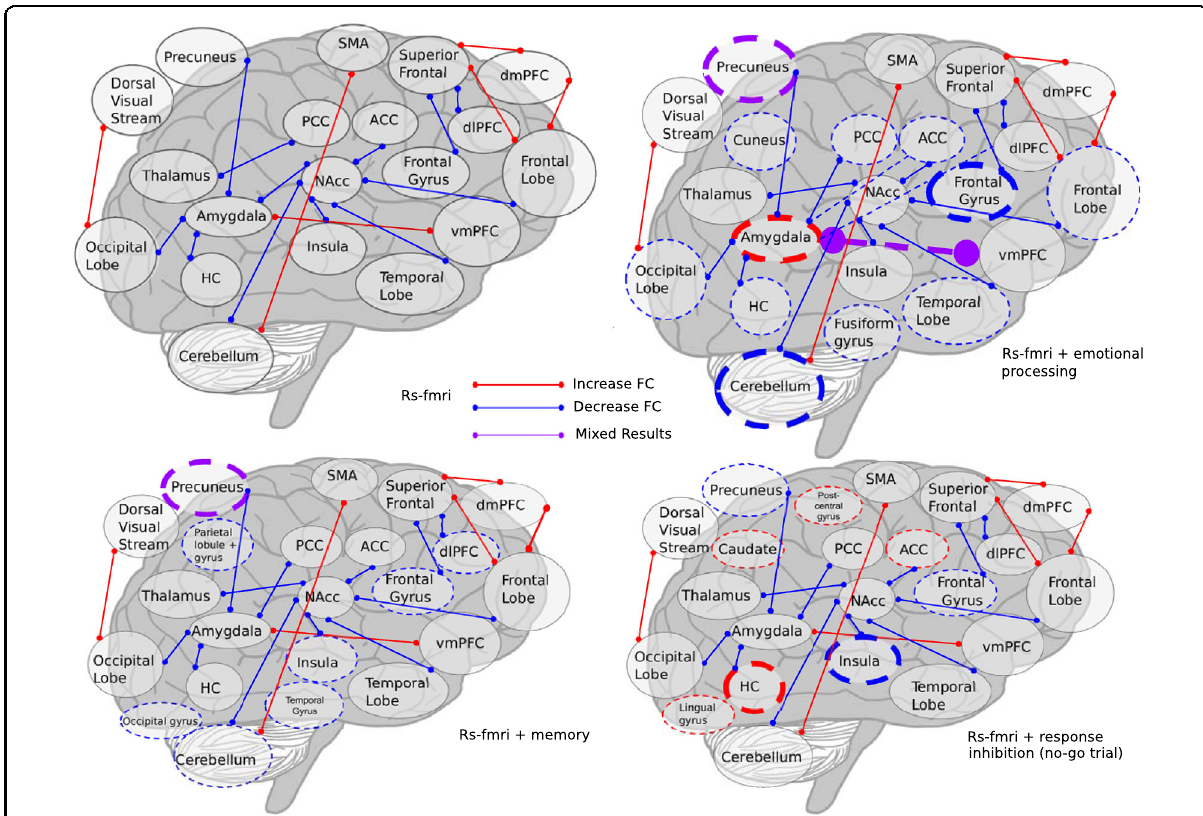
Fig. 3 Visualization of fMRI results with er fMRI superimposed on rs fMRI. a rs fMRI results, b rs and er fMRI results; emotional processing tasks, c rs and er fMRI results; memory tasks, d rs and er fMRI results, no-go trials from response inhibition. Thin lines indicate results from one study. Thick lines indicate results from two. Solid lines indicate rs fMRI, dashed indicate resting state. Colored circles demarcate “ activity ” lines indicate “ connectivity ”